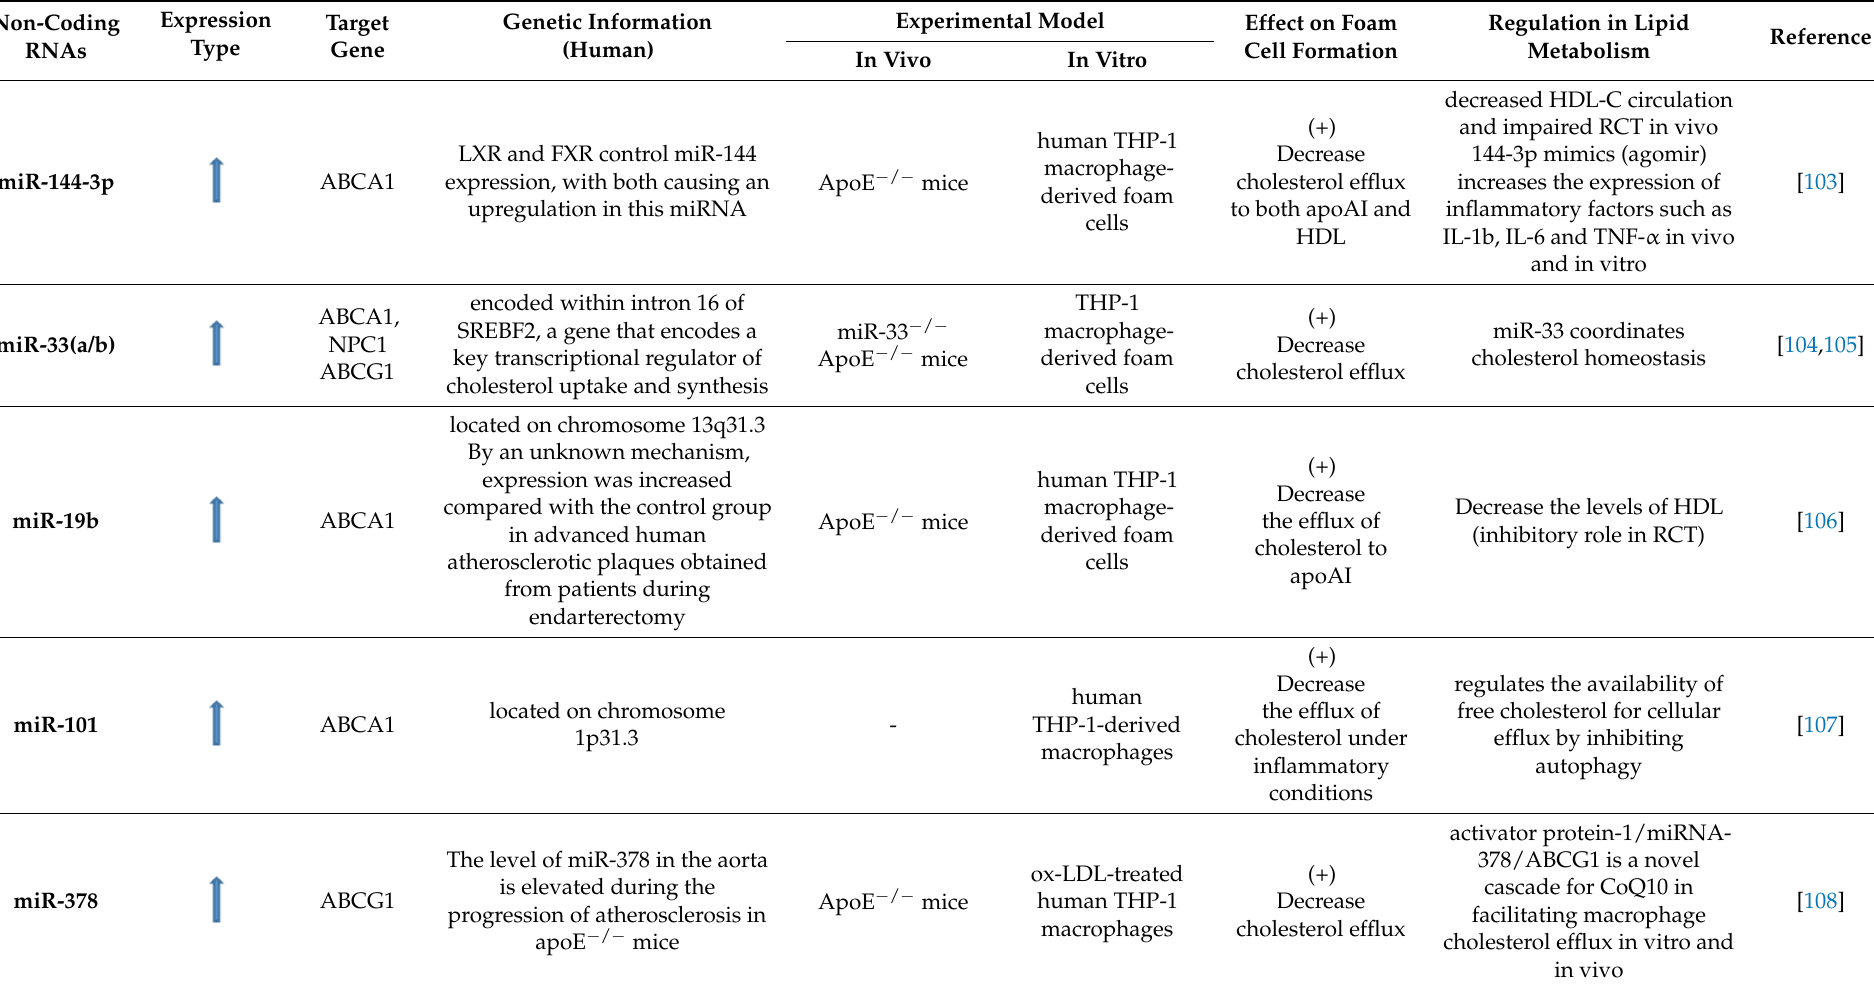
Table 1. Non-coding RNAs that stimulate foam cell formation/function.